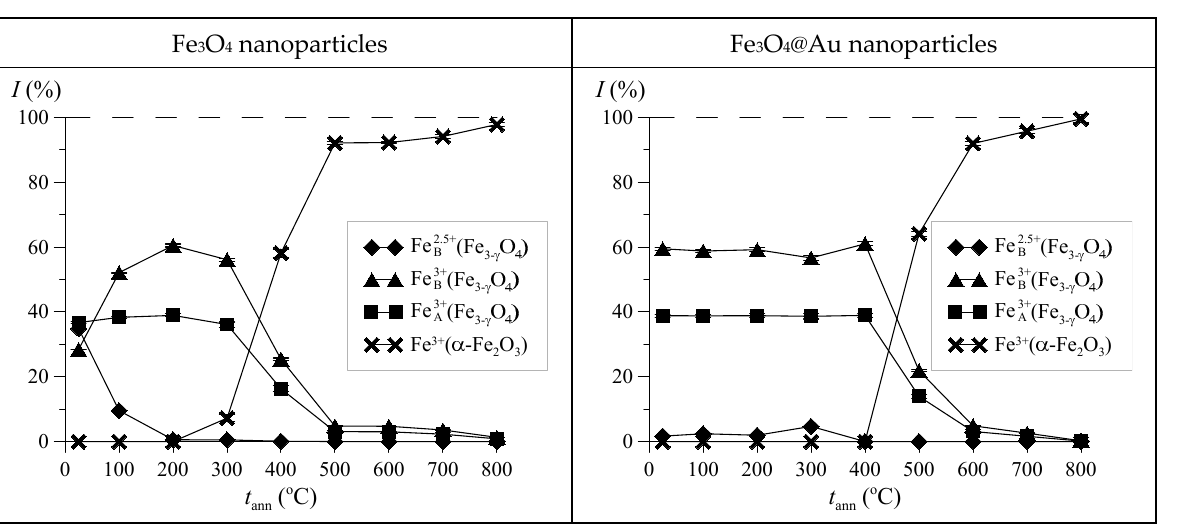
Figure 11. Relative intensities of subspectra corresponding to different states of Fe atoms in Fe 3 O 4 and Fe 3 O 4 @Au nanoparticles, depending on the annealing temperature t ann.